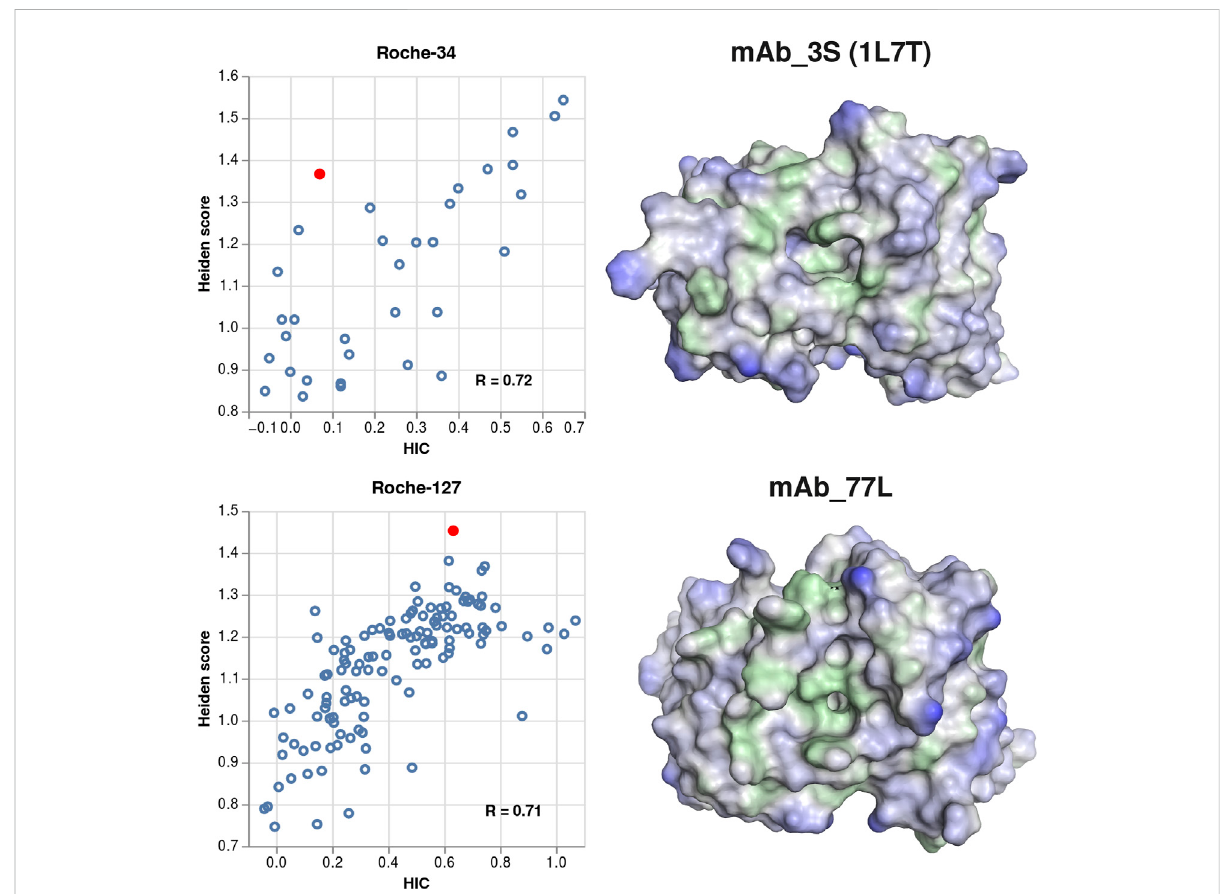
FIGURE 6 Examples for structures where cavities lead to over-prediction of the surface hydrophobicity. Left column: scatter plots showing the Heiden score vs. the experimental HIC values, for the Roche-34 set (top) and the Roche-127 set (bottom). In each plot, one antibody is marked, and the respective surface isshown attherightside. Green surfacecorresponds to hydrophobicregions (Heiden score > 0) and bluesurfacecorrespondsto hydrophilic regions (Heiden score <